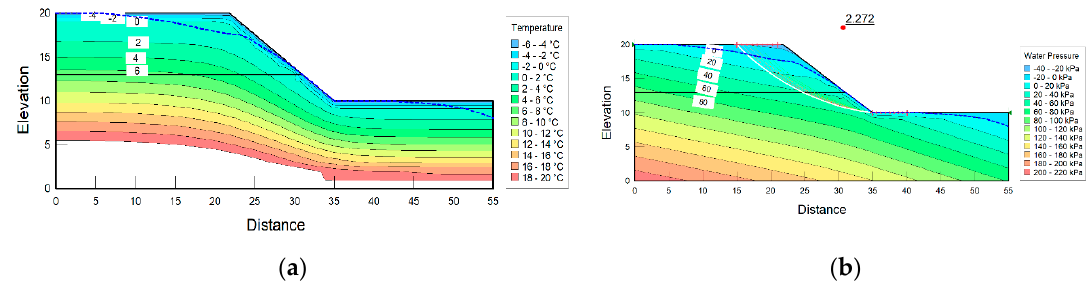
Figure 14. Coupled analysis using the modules TEMP/W, SEEP/W, and SLOPE/W. ( a ) Full thermal model analysis, ( b ) seepage and slope stability analysis.